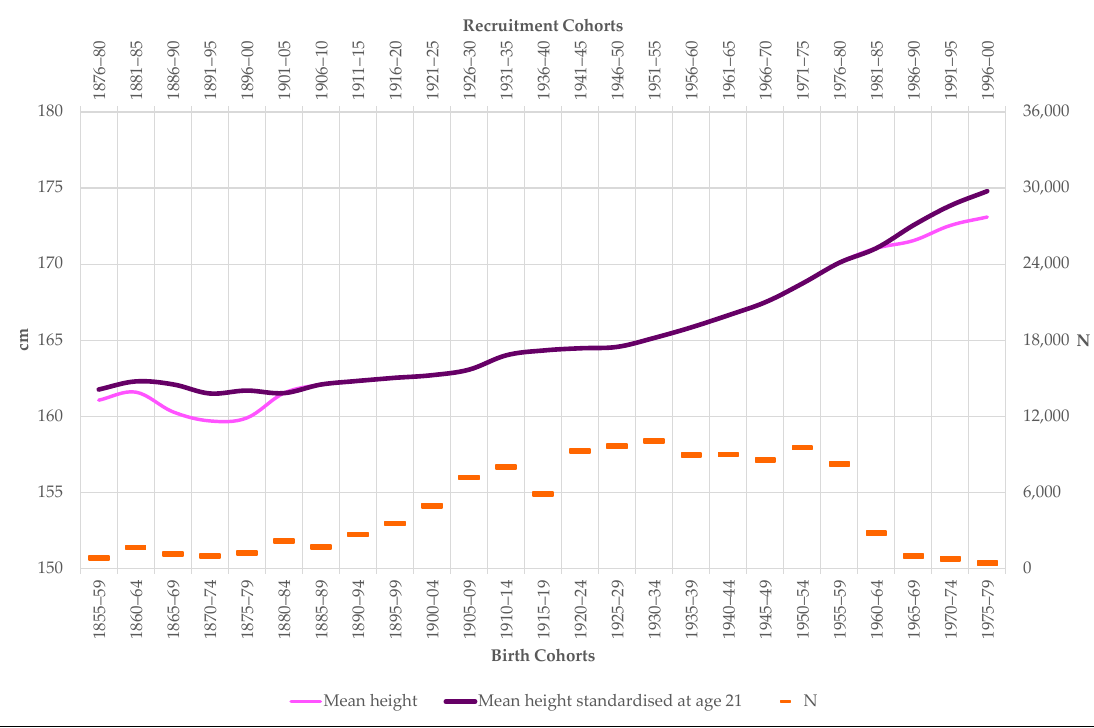
Figure 3. Number (N) and mean height (cm) of recruits included in the sample Extremadura.